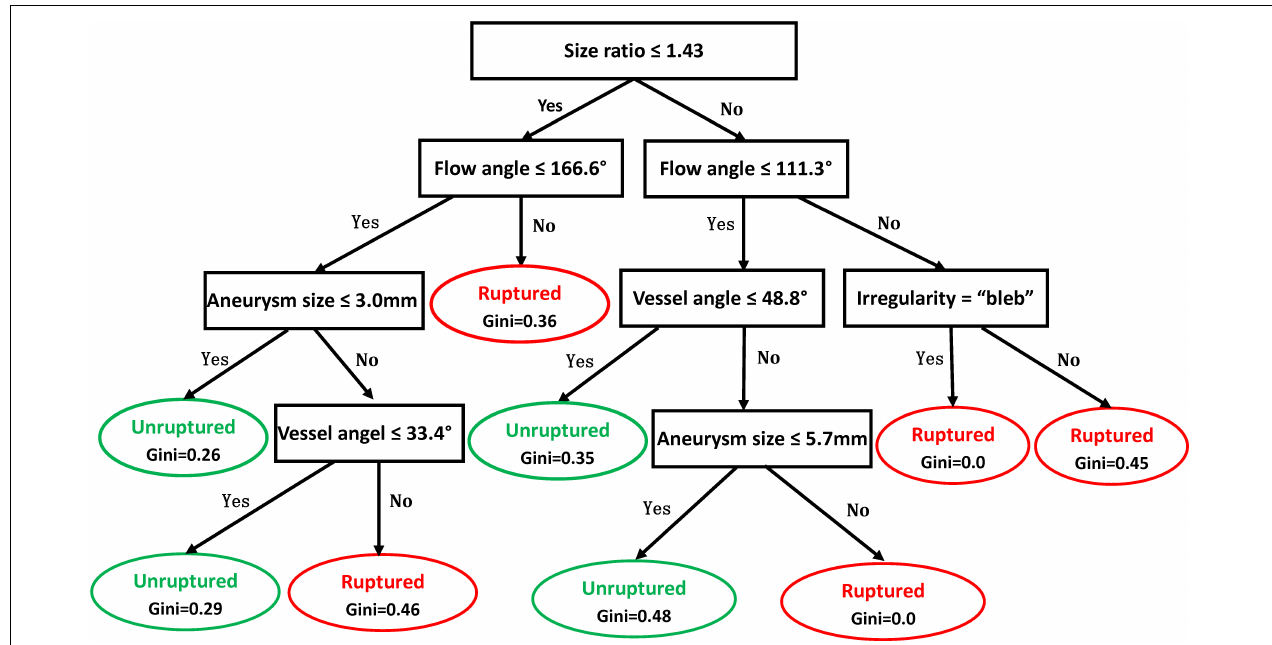
FIGURE 2 | Decision tree model for rupture risk assessment of anterior communicating artery (ACoA) aneurysms. In the decision tree, rectangle nodes represent conditions and elliptical nodes stand for the ruptured or unruptured status of the aneurysm predicted. One can start from the root node (i.e., “Size ratio ≤ 1.43”) and compare the value of the size ratio of an aneurysm with the not node. If it is true that the size ratio is less or equal to 1.43, then the next node of “Flow angle ≤ 166.6 ◦ ” can be moved; otherwise, jump to the node of “Flow angle 111.3 ◦ .” Continue comparing the attribute value of an aneurysm with other internal nodes of the decision tree until an elliptical node is reached, at which point the predicted status, ruptured or unruptured, is obtained.